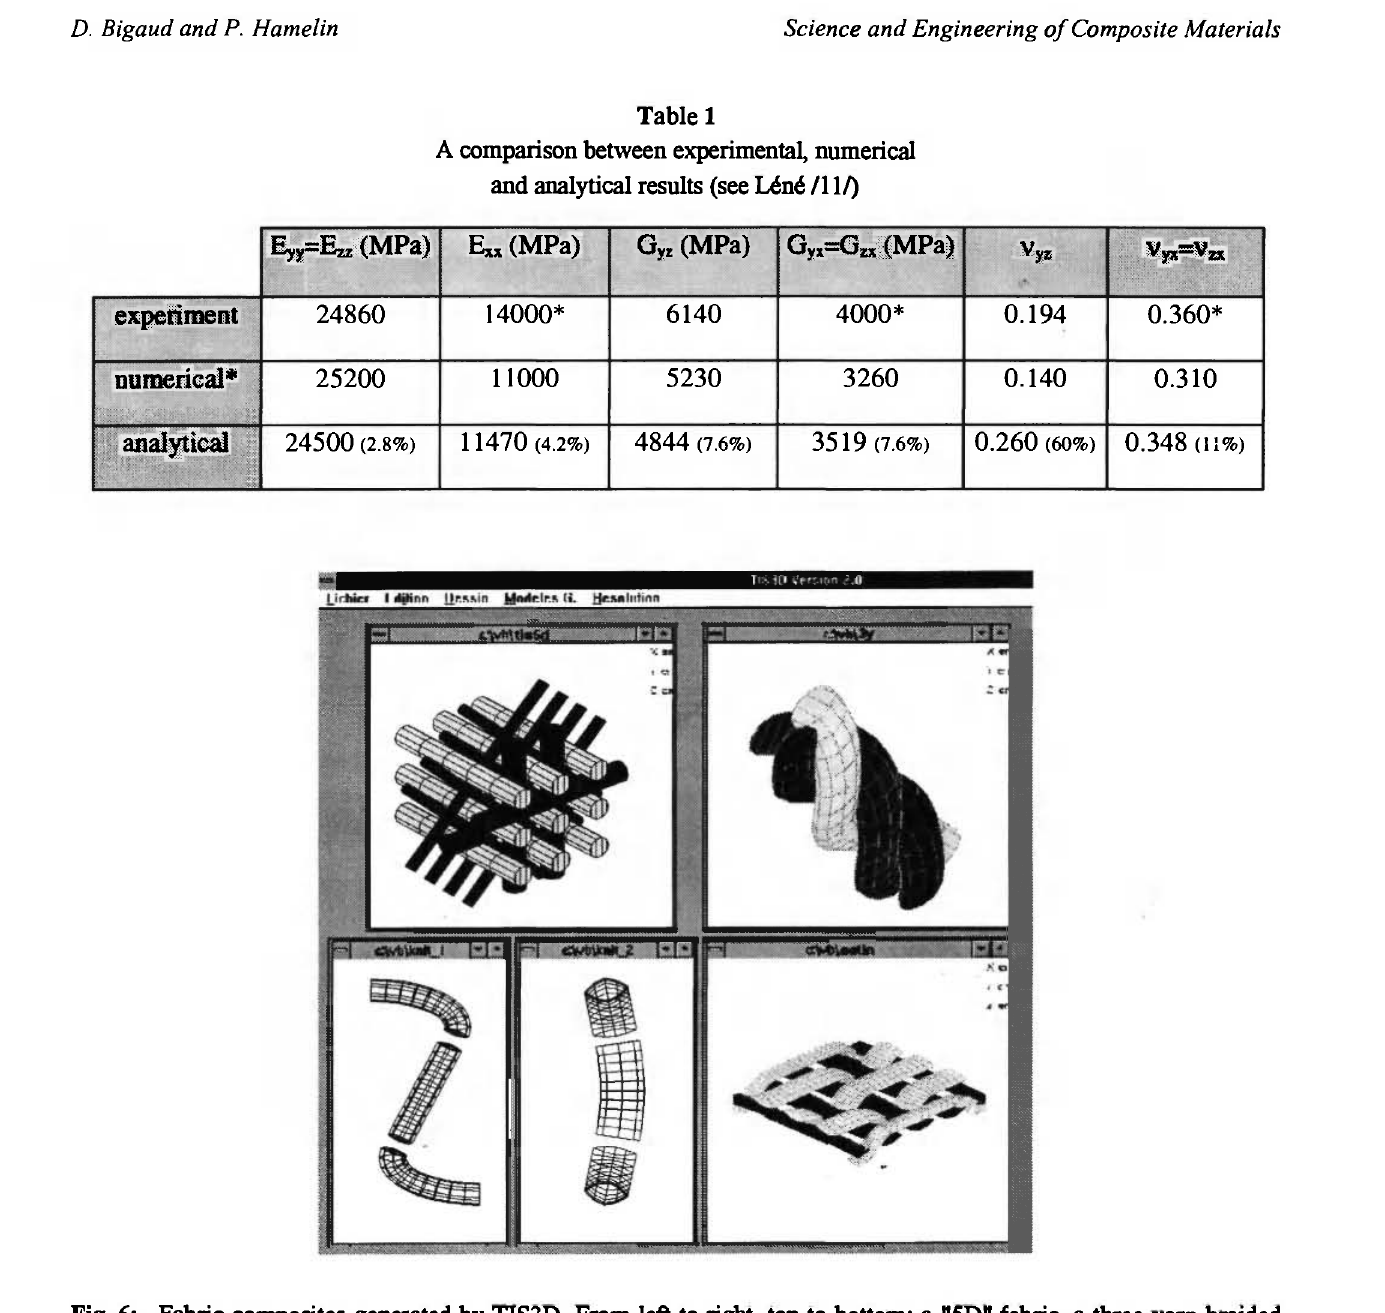
Fig. 6: Fabric composites generated by TIS3D. From left to right, top to bottom: a "5D" fabric, a three-yarn-braided fabric, elements of knitted fabric, a satin-woven